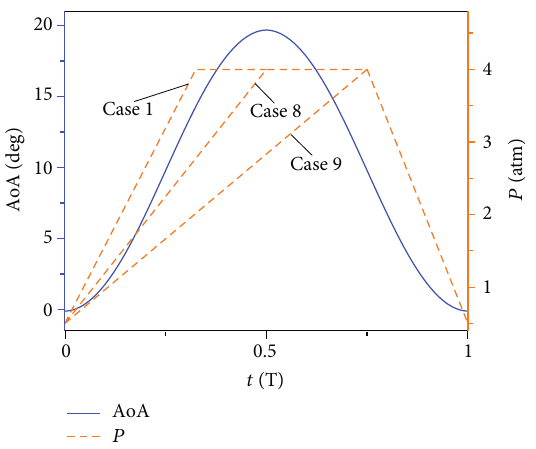
Figure 32: Control laws of in fl ation and de fl ation for Cases 1, 8, and